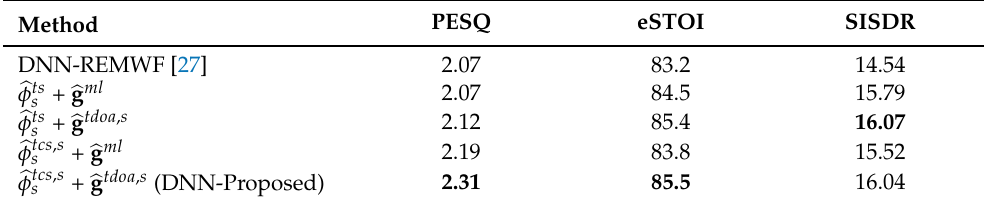
Table 5. The PESQ scores, eSTOIs, and SISDRs averaged over all noise types for the proposed method with DNN-based a priori SPP estimation by replacing the proposed sub-modules with conventional ones, one by